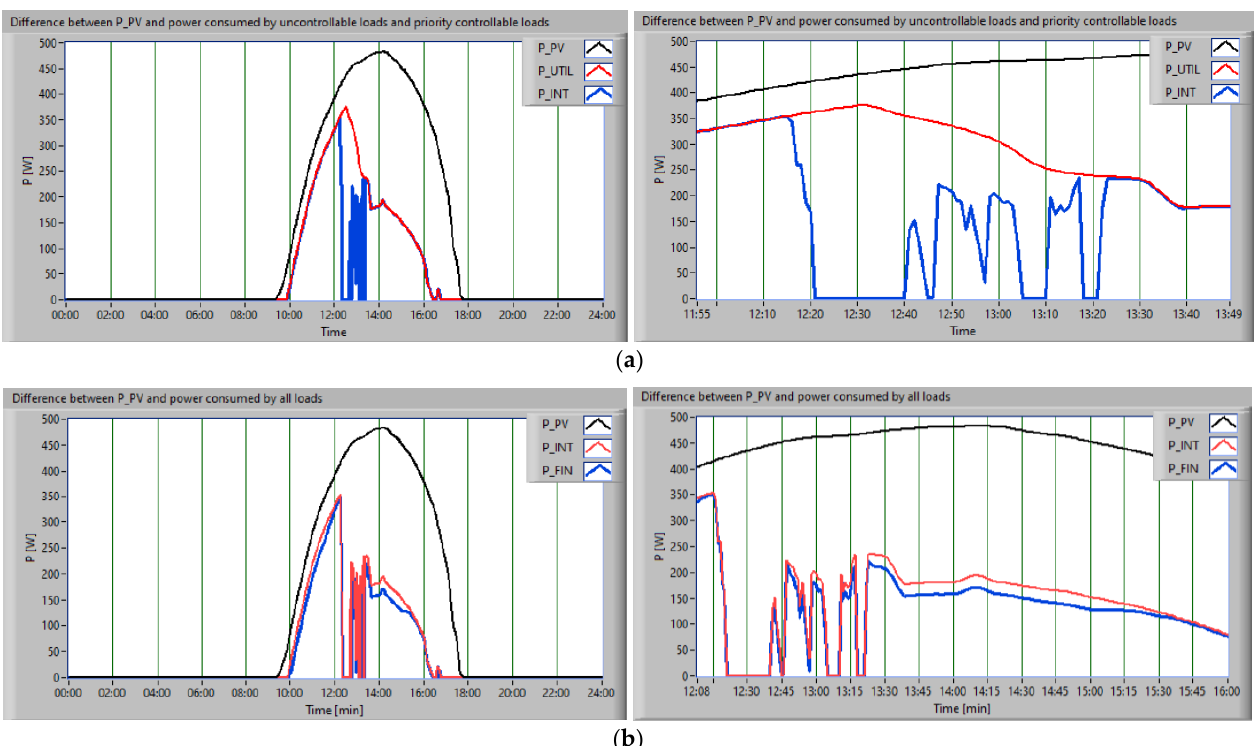
Figure 12. Priority assignments for loads in scheduling approach, scenario 2.